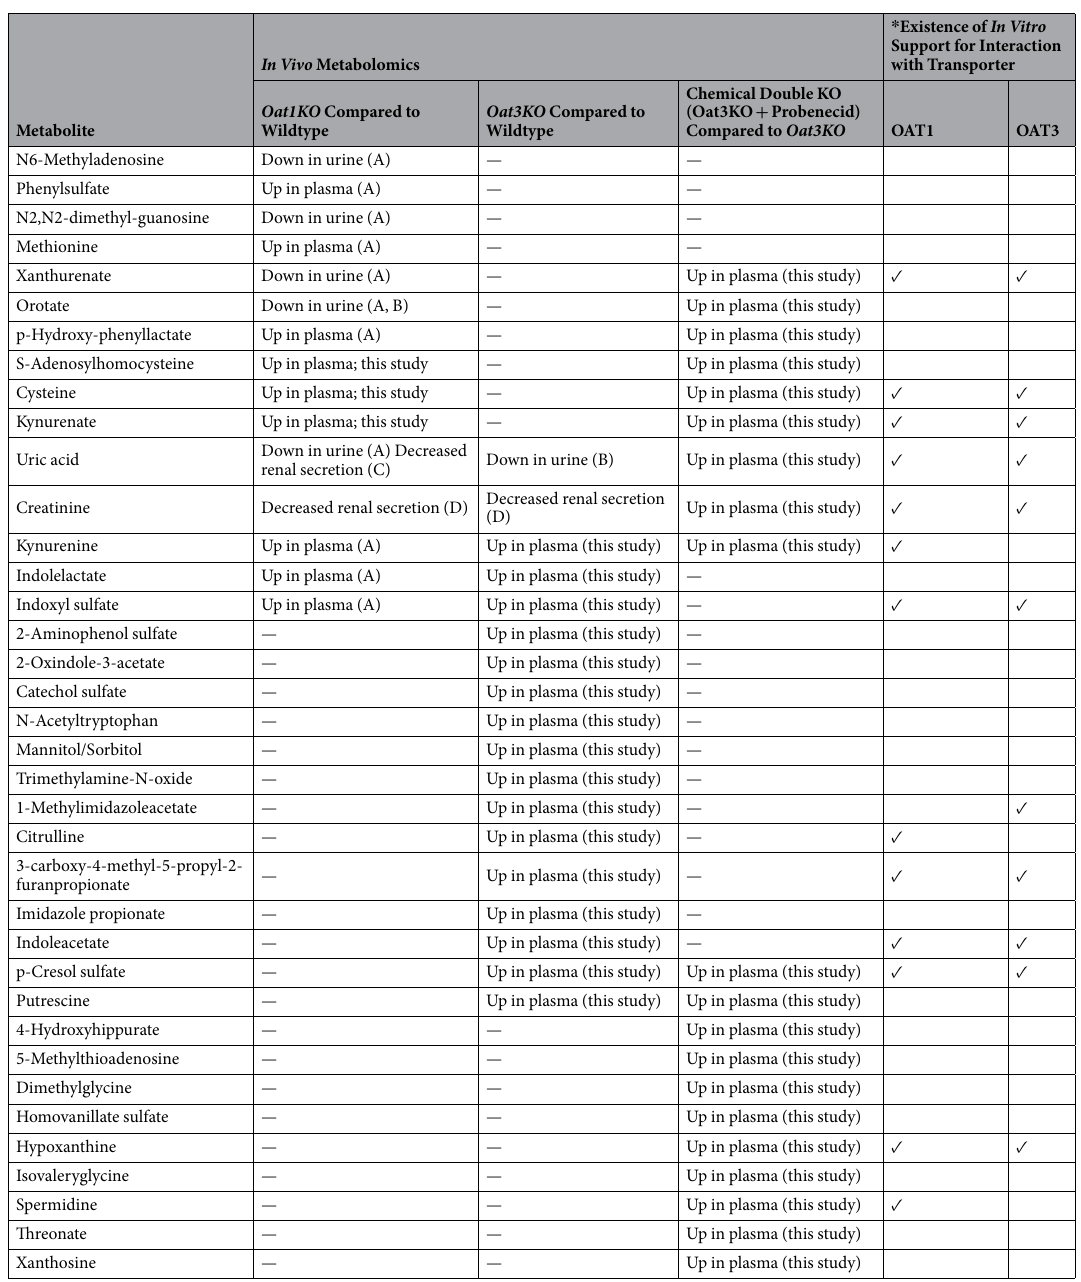
— — Up in plasma (this study) Table 3. Uremic Toxins and/or Retention Solutes Interactions with Oat1KO, Oat3KO, or Chemical Double Knockout. (A − D) Columns 2–3 indicate findings from previous studies: A–PMID: 2147660, B– PMID:16354673; C – PMID: 18270321; D–PMID: 22338083. ( − ) Columns 2–4 indicate no significant change detected in plasma concentration of the indicated metabolite in the in vivo metabolomics analyses. Blanks in Columns 5–6 indicate that in vitro uptake/inhibition studies have not been performed for the indicated metabolite. * See Supplemental Table 2 for Km, Ki, IC50 and